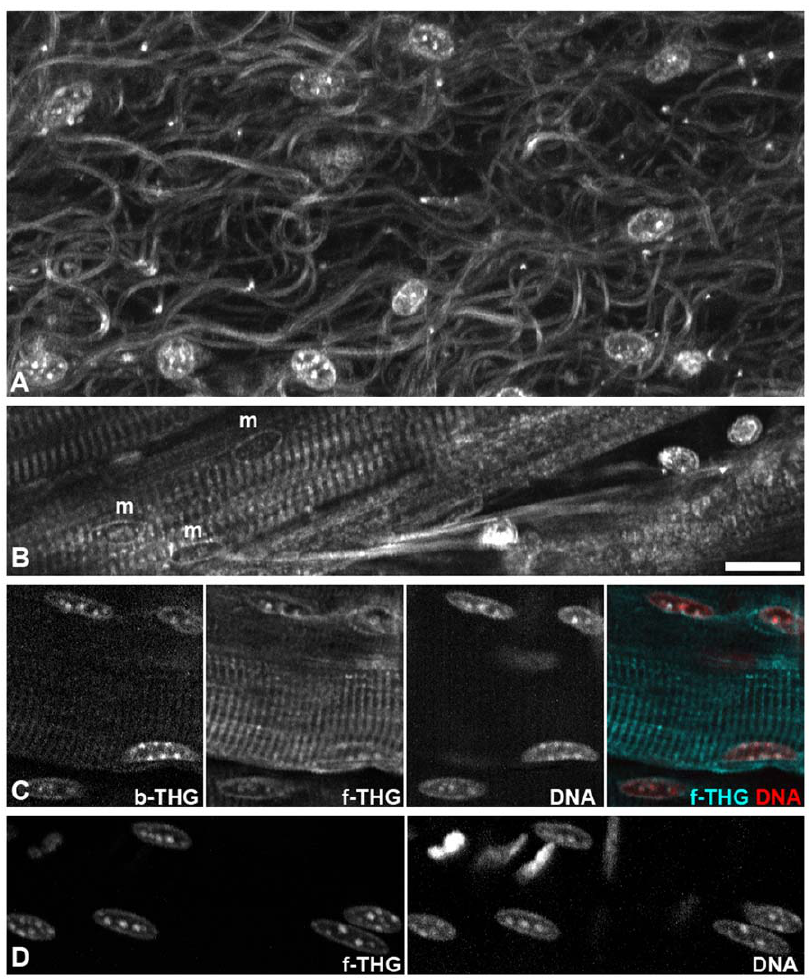
Figure 4. Nuclei and chromatin structure. A,B) Single optical forward THG sections from unstained, explanted cremaster. A, Section near the surface, nuclei most likely belong to macrophages. B, In deeper regions, nuclei of muscle fibers (m) can be observed, in addition to leukocytes. C,D) Nuclei in the cremaster after DNA-staining with Draq5. Chromocenters colocalize in THG channels and by DNA staining. C, Single optical section. D, Projections of five sections spaced 3 m m each. Not all DNA-stained-nuclei are visible in THG. Scale bar 20 m m for all